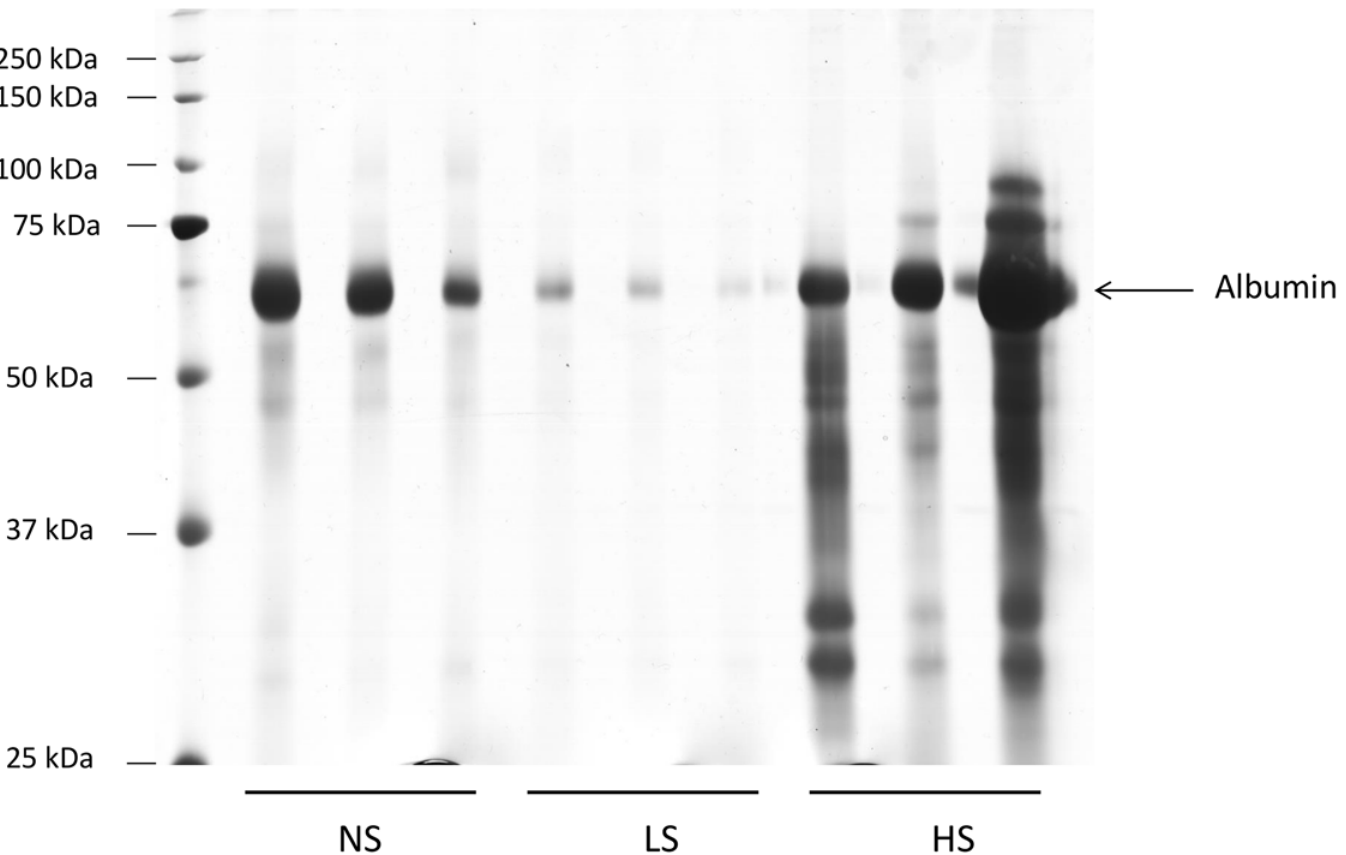
Fig 2. Evaluation of the urinary protein loss. 24-h urine samples from SHRs were subjected to 12% SDS-PAGE and silver stained. NS: normal salt diet. LS: low salt diet. HS: high salt diet.